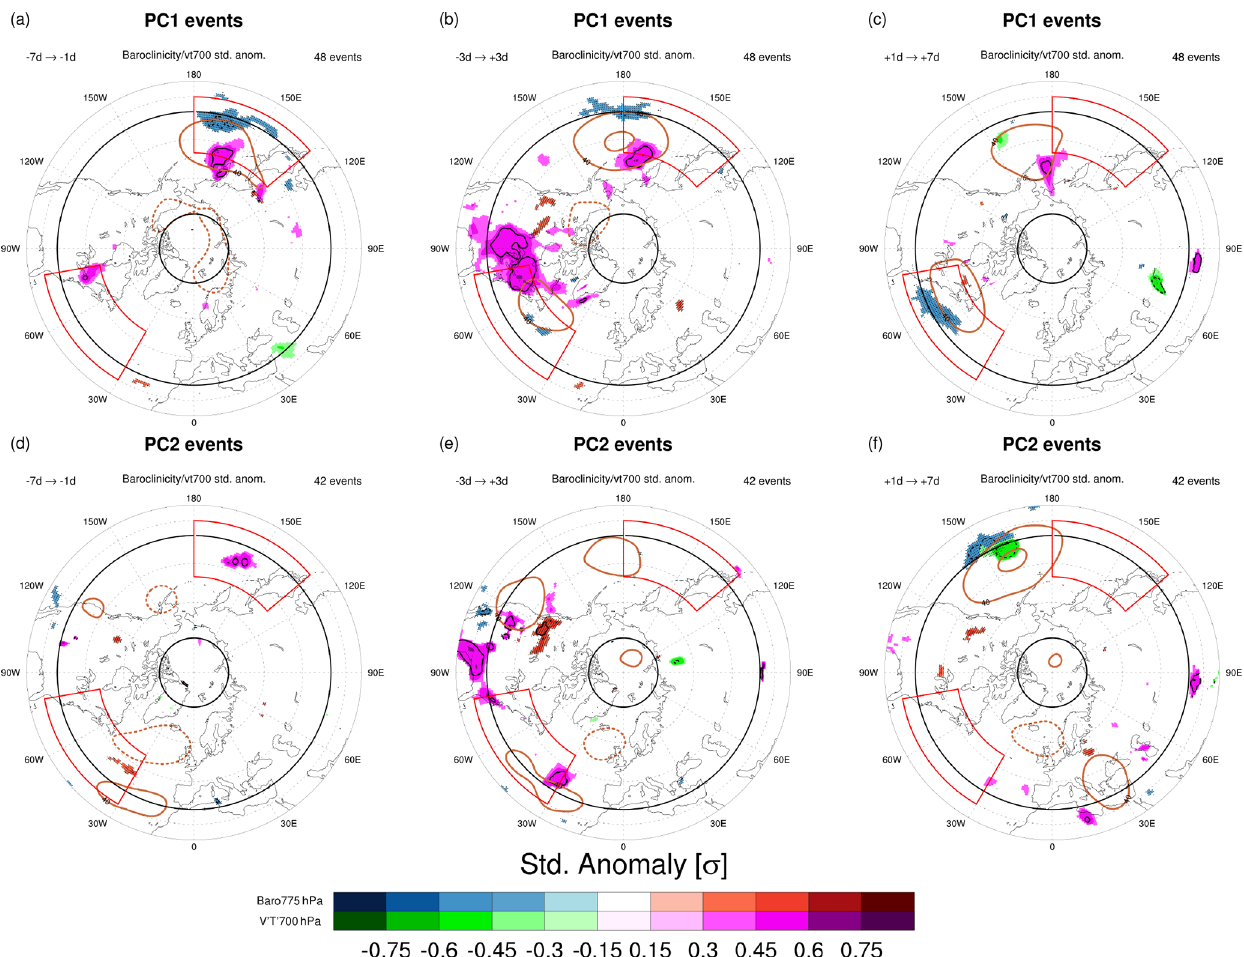
Figure 9. Lagged composites of significant ( p < 0 . 01, two-sided t test) heptad-mean standardized anomalies of 775hPa baroclinicity s and 700hPa transient meridional heat flux v ∗ T ∗ (shaded), together with heptad-mean geopotential height anomalies (brown contours; only − 40, + 40 and + 80m), for (a–c) CRWP1 and (d–f) CRWP2 events. Standardized anomalies of s and v ∗ T ∗ higher (lower) than + 0 . 5 σ ( − 0 . 5 σ ) are contoured by a bold continuous (dotted) black contour; stippling is added on top of s anomalies to distinguish them further in case of overlap. The heptads centered at (a, d) t max − 4d, (b, e) t max and (c, f) t max + 4d are shown. The two storm track regions, where areal averaging to obtain the time series of Fig. 8 was performed, are indicated in red. Bold black latitude circles indicate 35 and 75 ◦